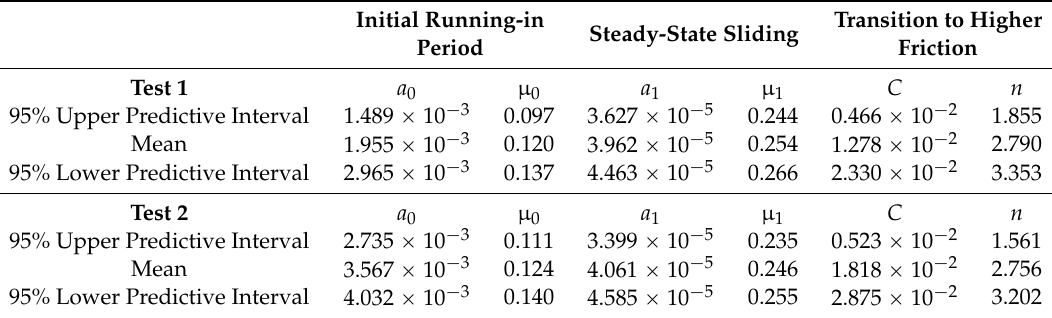
Table 3. Estimated parameters using the measured data of Test 1, Test 2 for the case of 50 N normal force with 1 mm displacement and 1 Hz frequency.